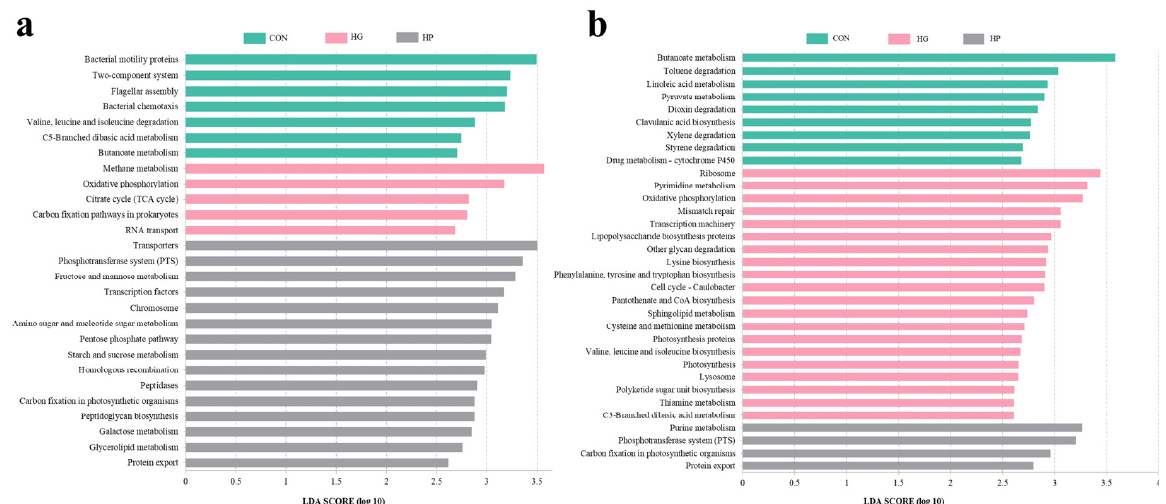
Figure 6. The alterations in the metabolic functions of jejunal digesta- ( a ) and mucosa- ( b ) associated microbiota at the KEGG level 3 in Hu sheep (n = 5) fed the CON, HG, and HP diets. CON, the control group; HG, the high-grain group; HP, the pelleted high-grain group.